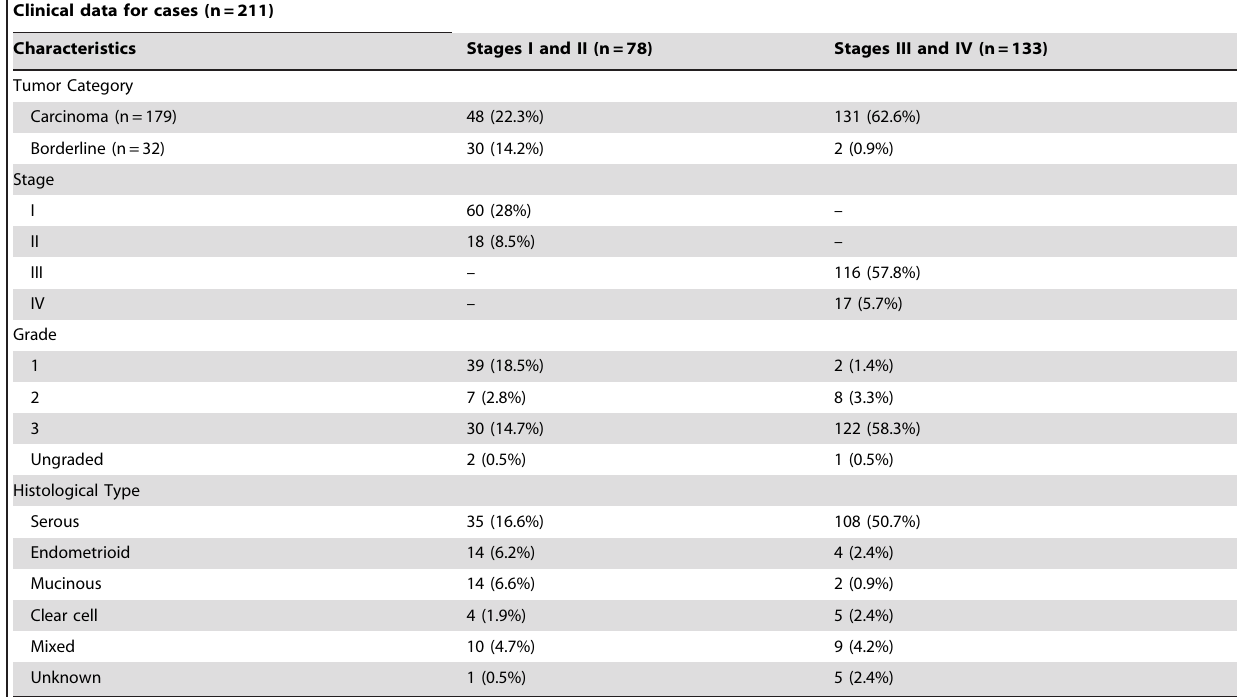
Table 1. Histopathology of epithelial ovarian cancer